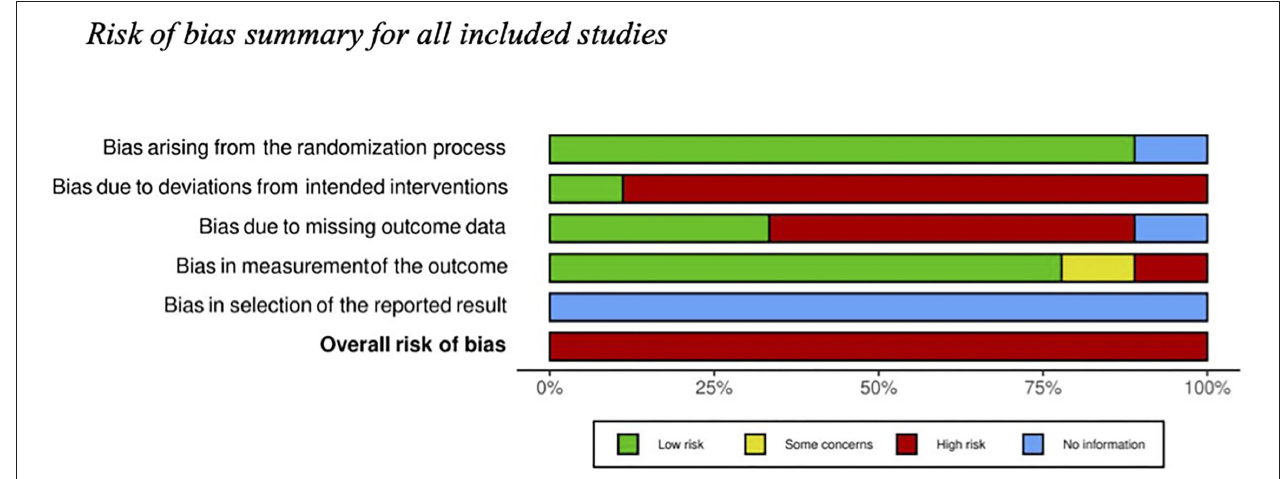
FIGURE 3 | Risk of bias summary across randomized controlled